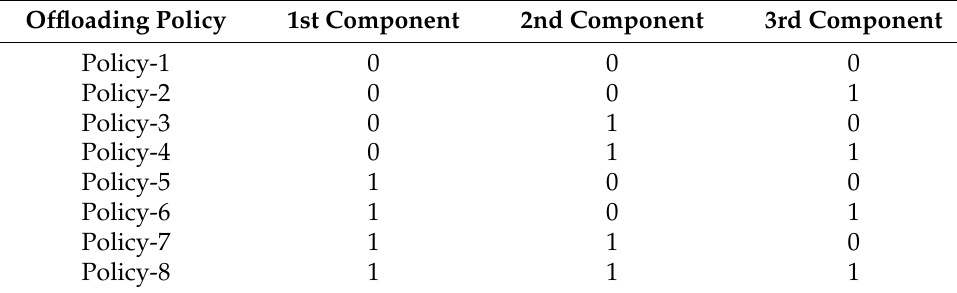
Table 1. All offloading policies for three